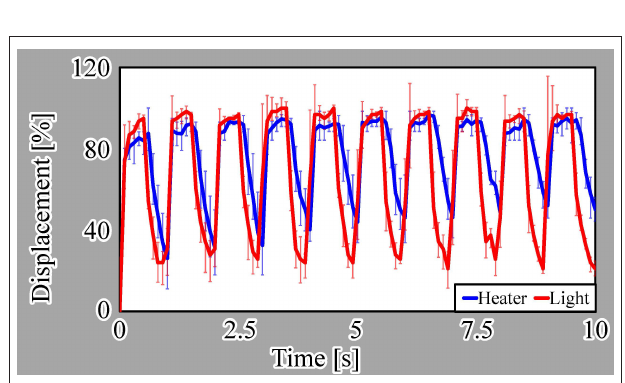
FIGURE 8 | Initial ten cycles of actuators driven by both